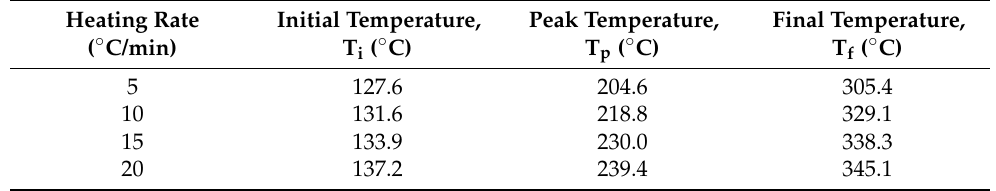
Table 1. Characteristic temperatures of the matrix resin obtained from the DSC curves at different heating